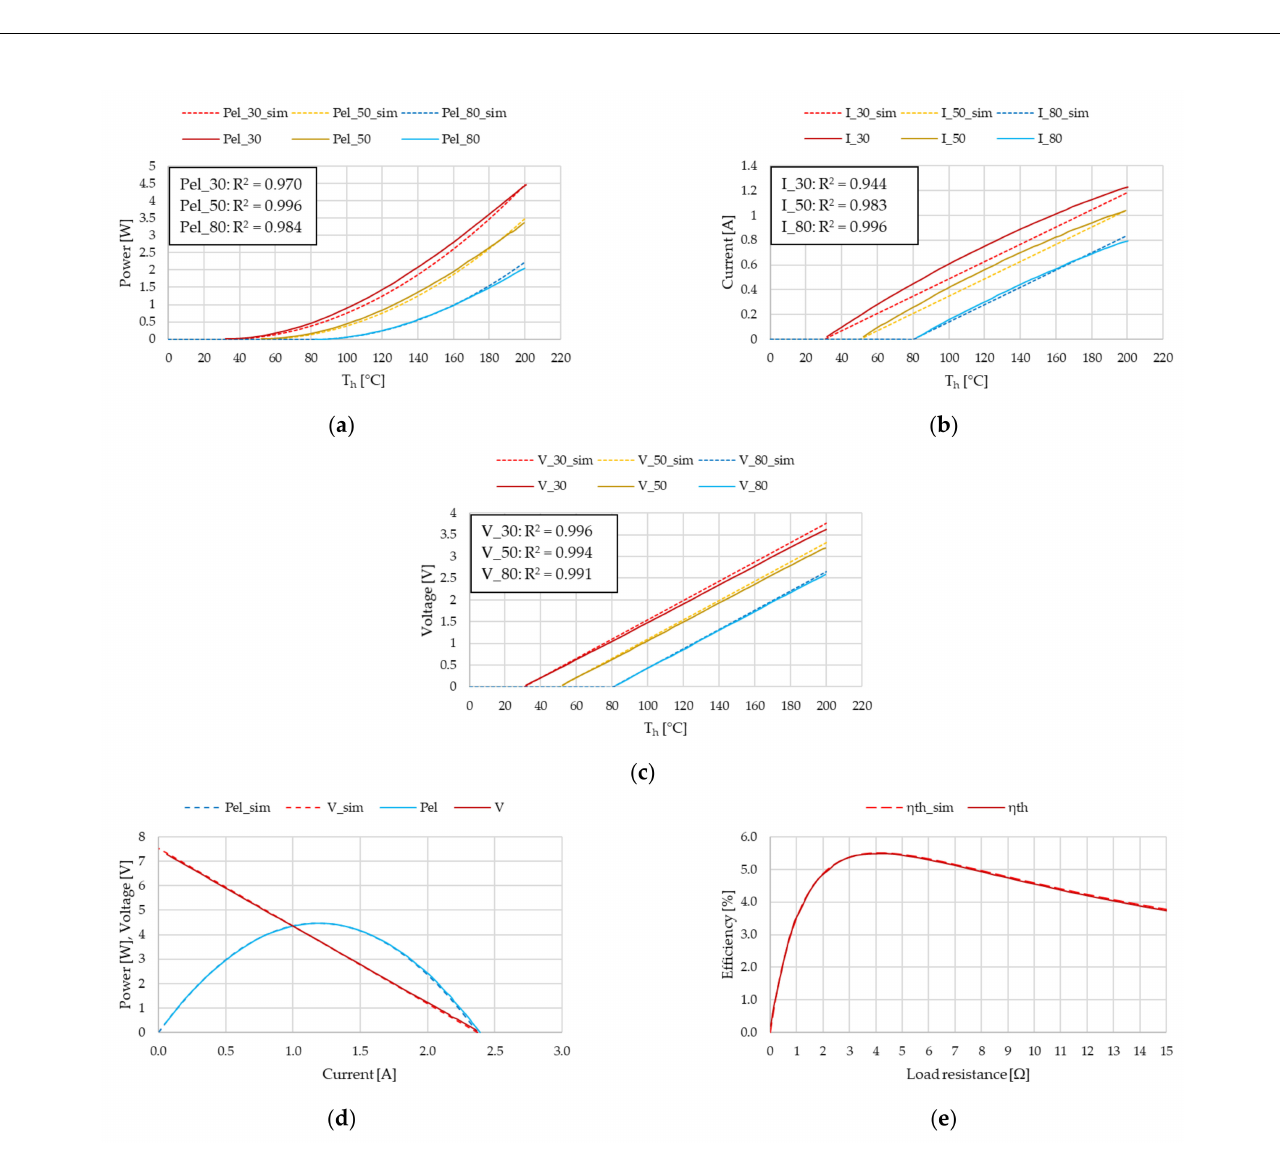
Figure 5. Manufacturer data compared to calculated data at matched load resistance conditions for TGM-127-1.4-2.5: ( a ) Module power; ( b ) module current; ( c ) module voltage; ( d ) module power and voltage with respect to current; and ( e ) module